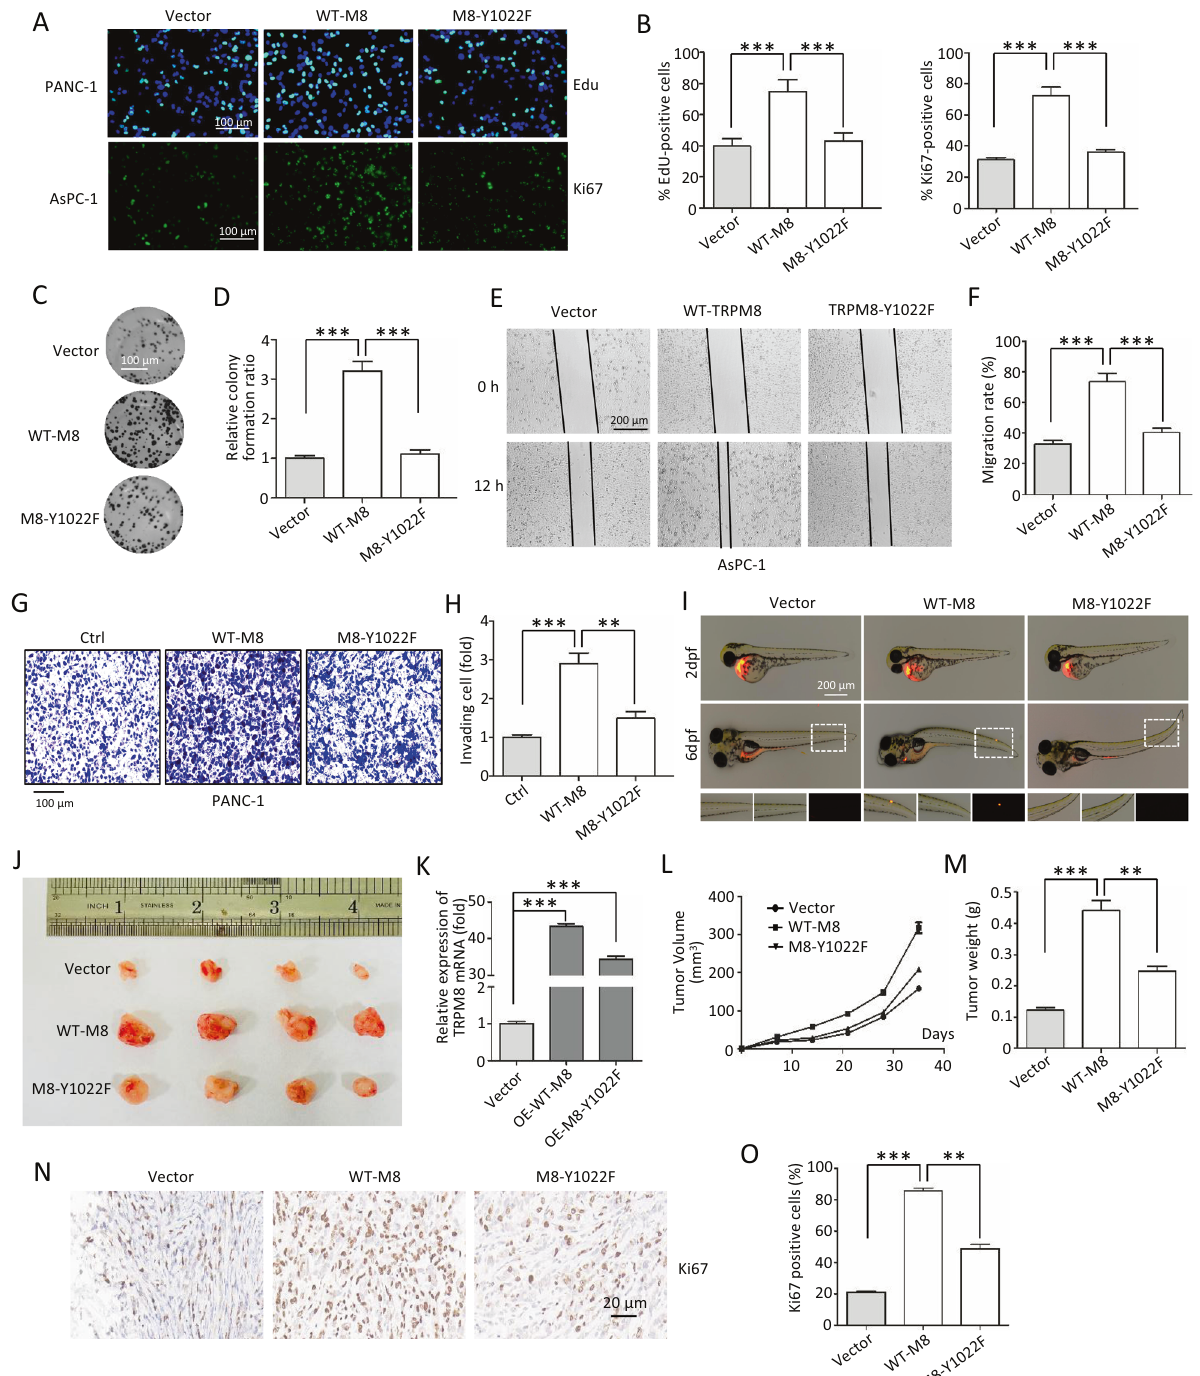
Fig. 8 The role of Y1022 on TRPM8 on tumor cell proliferation, migration, and tumorigenesis. A – D Cell proliferation assays in vitro. A , B The RFP labeled cell lines of PANC-1 or AsPC-1 cells stably expressing control vector, WT-TRPM8, or mutant TRPM8-Y1022F were constructed and used for EdU incorporation assays (Upper panel) and Ki67 immuno fl uorescence (Lower panel). Scale bars, 100 µm. C , D Colony formation assays were performed in RFP labeled PANC-1 stably maintained cells. Scale bars, 100 µm. E – I Cell migration assays. Scale bars, 200 µm. E , F Wound-healing assay was performed in RFP labeled AsPC-1 stably maintained cells. G , H Transwell assay was performed in RFP labeled PANC-1 stably maintained cells. Scale bars, 100 µm. I – L Animal xenotransplantation engraftment experiments. I Representative confocal microscopy images of 6 days xenotransplantation of zebra fi sh injecting with RFP labeled PANC-1 stably maintained cells. Scale bars, 200 µm. J Imaging of tumors excised from the mice subcutaneously injecting RFP labeled PANC-1 stably maintained cells by growth for 5 weeks. K Quanti fi cation of the expression of TRPM8 mRNA in ( J ). L Weights of the excised tumors in each group in ( J ). M Growth curves showing the changes in the tumor volume in mice in different groups every 5 days from the injection. N Representative H&E staining images and immunohistochemical images of Ki67 in excised tumors tissues. Scale bars, 20 µm. O Quanti fi cation of Ki67 expression in ( N ). ** P < 0.01, *** P < 0.001. Data are presented as mean ± SEM. All studies were repeated at least three